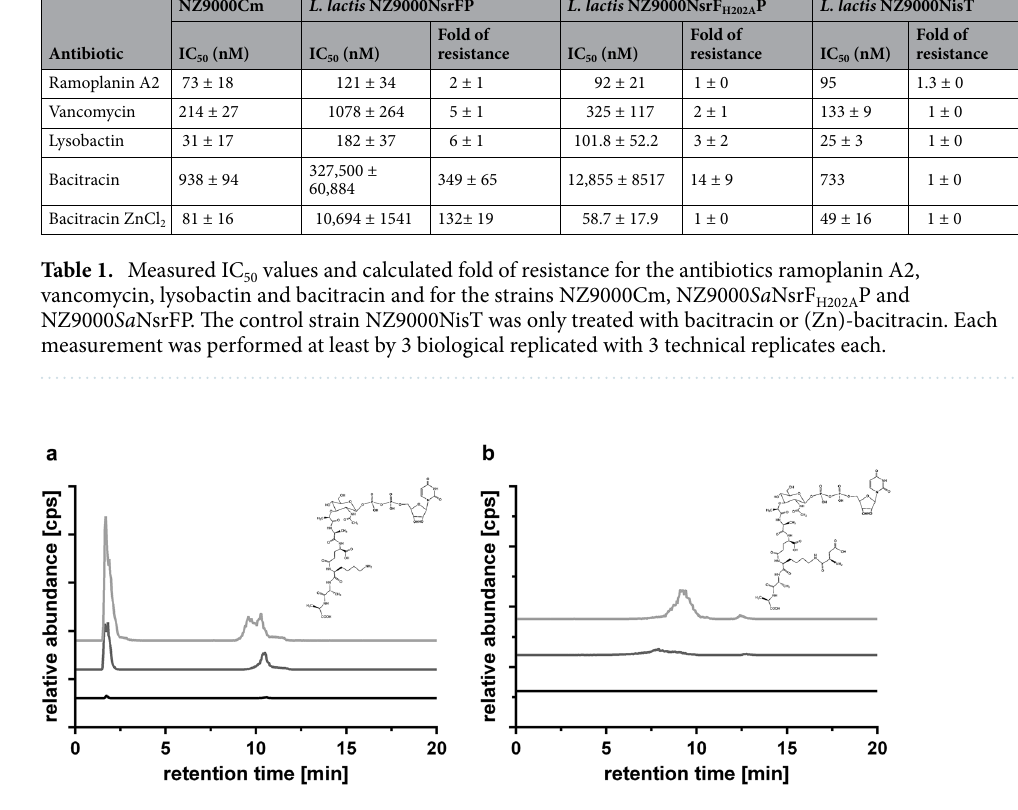
Figure 4. Relative abundance of obtained mass in cps against retention time in min of precursor accumulation after treatment with bacitracin. ( a ) Extracted ion chromatography (EIC) spectrum for UDP-MurNAc-l-Ala- d-iGlu-l-Lys-d-Ala-d-Ala (1148.4 m/z −1 ) and ( b ) EIC spectrum for UDP-MurNAc-l-Ala-d-iGlu-l-Lys(d- Asp)-d-Ala-d-Ala (1263.4 m/z −1 ) of the strains NZ9000Cm (light gray), NZ9000 Sa NsrF H202A P (gray) and NZ9000 Sa NsrFP (black). Extracted ion chromatograms (EICs) in negative ion mode for UDP-MurNAc-l-Ala- d-iGlu-l-Lys-d-Ala-d-Ala (m/z −1 1148.34 ± 0.1) and UDP-MurNAc-l-Ala-d-iGlu-l-Lys-(d-Asp)-d-Ala-d- Ala (m/z −1 1263.37 ± 0.1) were analyzed with Data Analysis (Bruker), exported and presented with GraphPad Prism 6.0, GraphPad Software, San Diego, California USA, www. graph pad. com. UDP undecaprenyl-phosphate, MurNAc N -acetylmuramic acid, Ala alanine, iGlu isoglutamic acid, Glu glutamine, Asp aspartate/aspartic acid, Lys